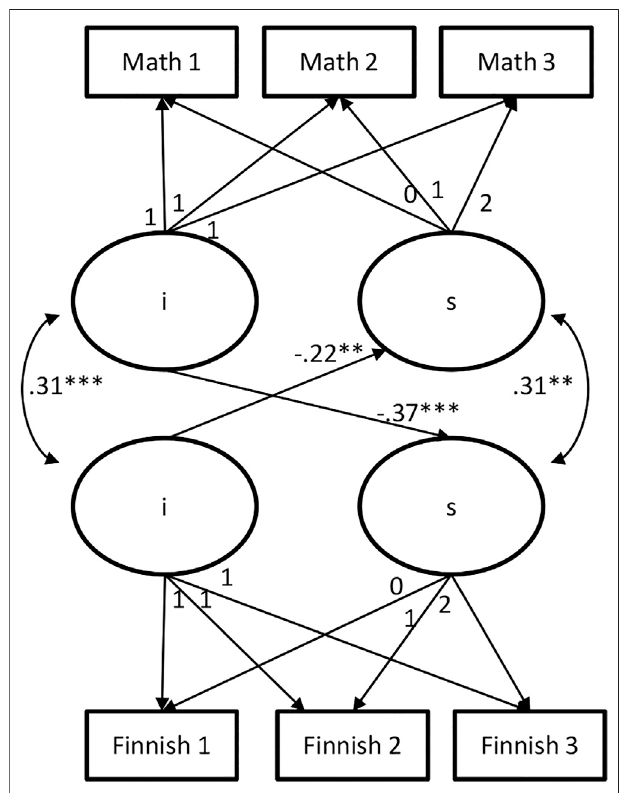
FIGURE 3 | The Parallel Process LGC Model of Math/Science Interest and Finnish Interest Among Finnish Students. Note.** p < 0.01; *** p < 0.001. I (cid:1) intersect, s (cid:1) slope.